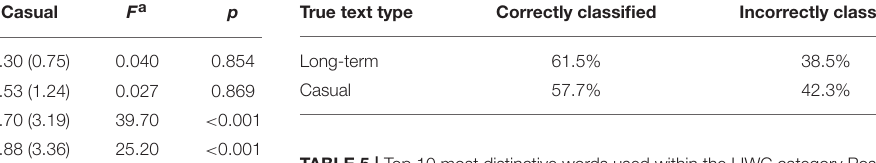
TABLE 5 | Top 10 most distinctive words used within the LIWC category Positive Emotion Words with the log-likelihood ratio score